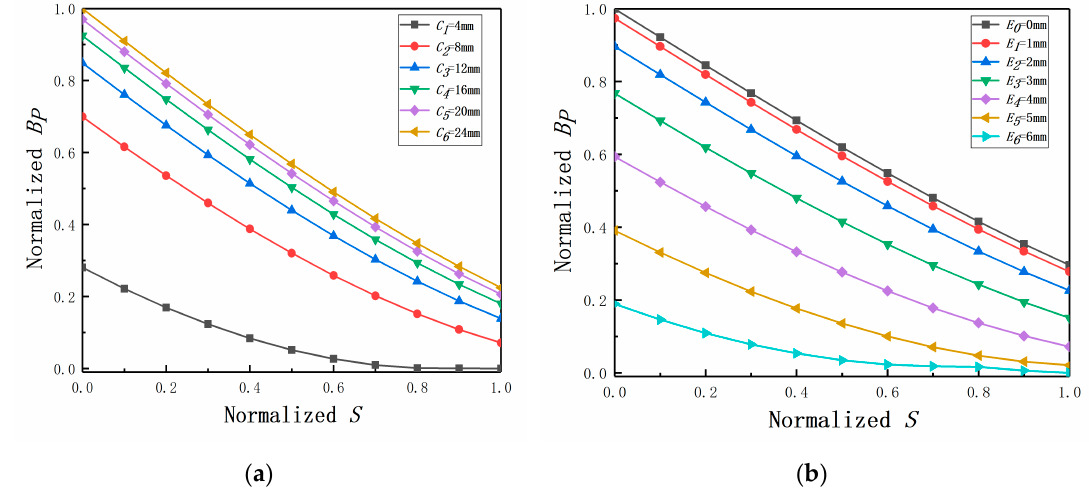
ff erent radii; ( b ) di ff erent